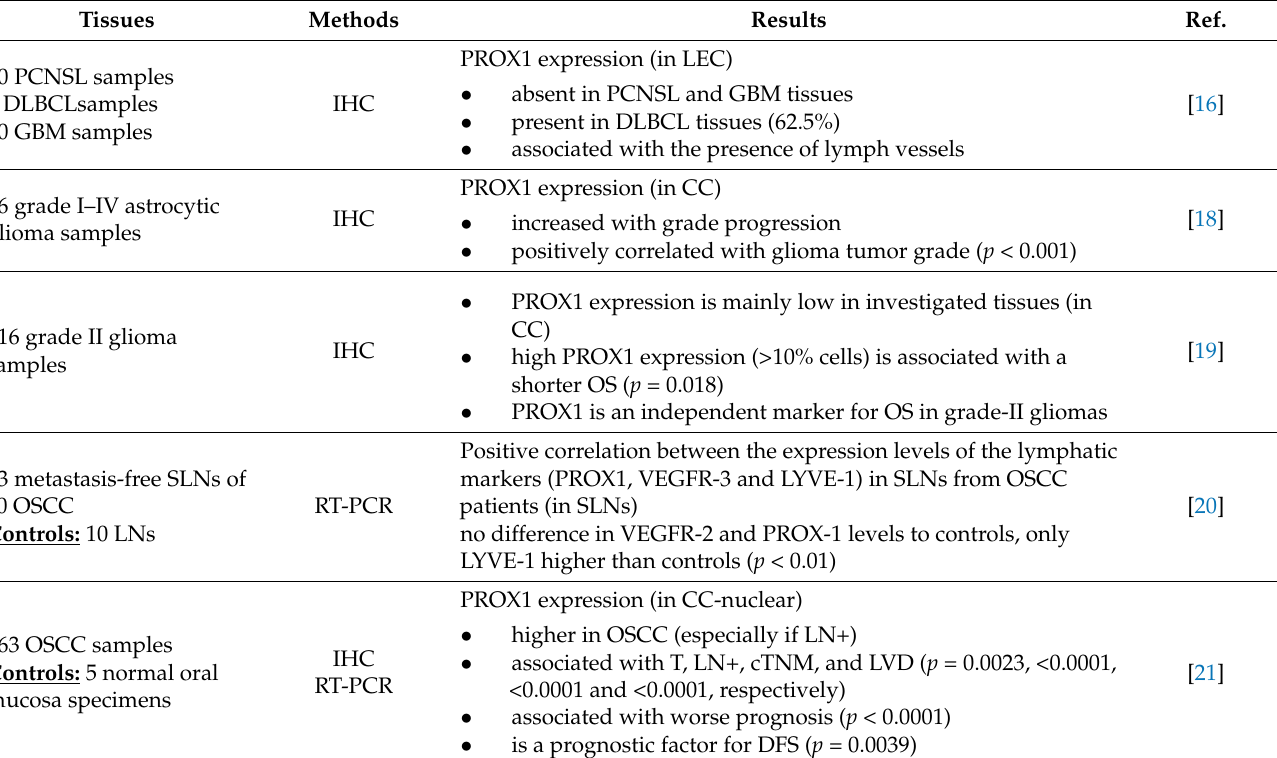
Table 1. PROX1 expression in CNS, oral squamous cell and thyroid cancer tissues, and clinicopatho- logical associations. Results